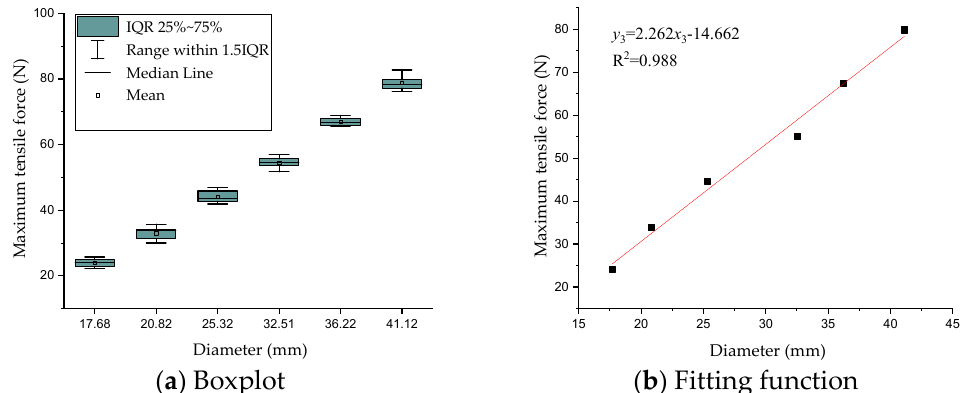
Figure 8. Boxplot and fitting function of transverse maximum tensile force.